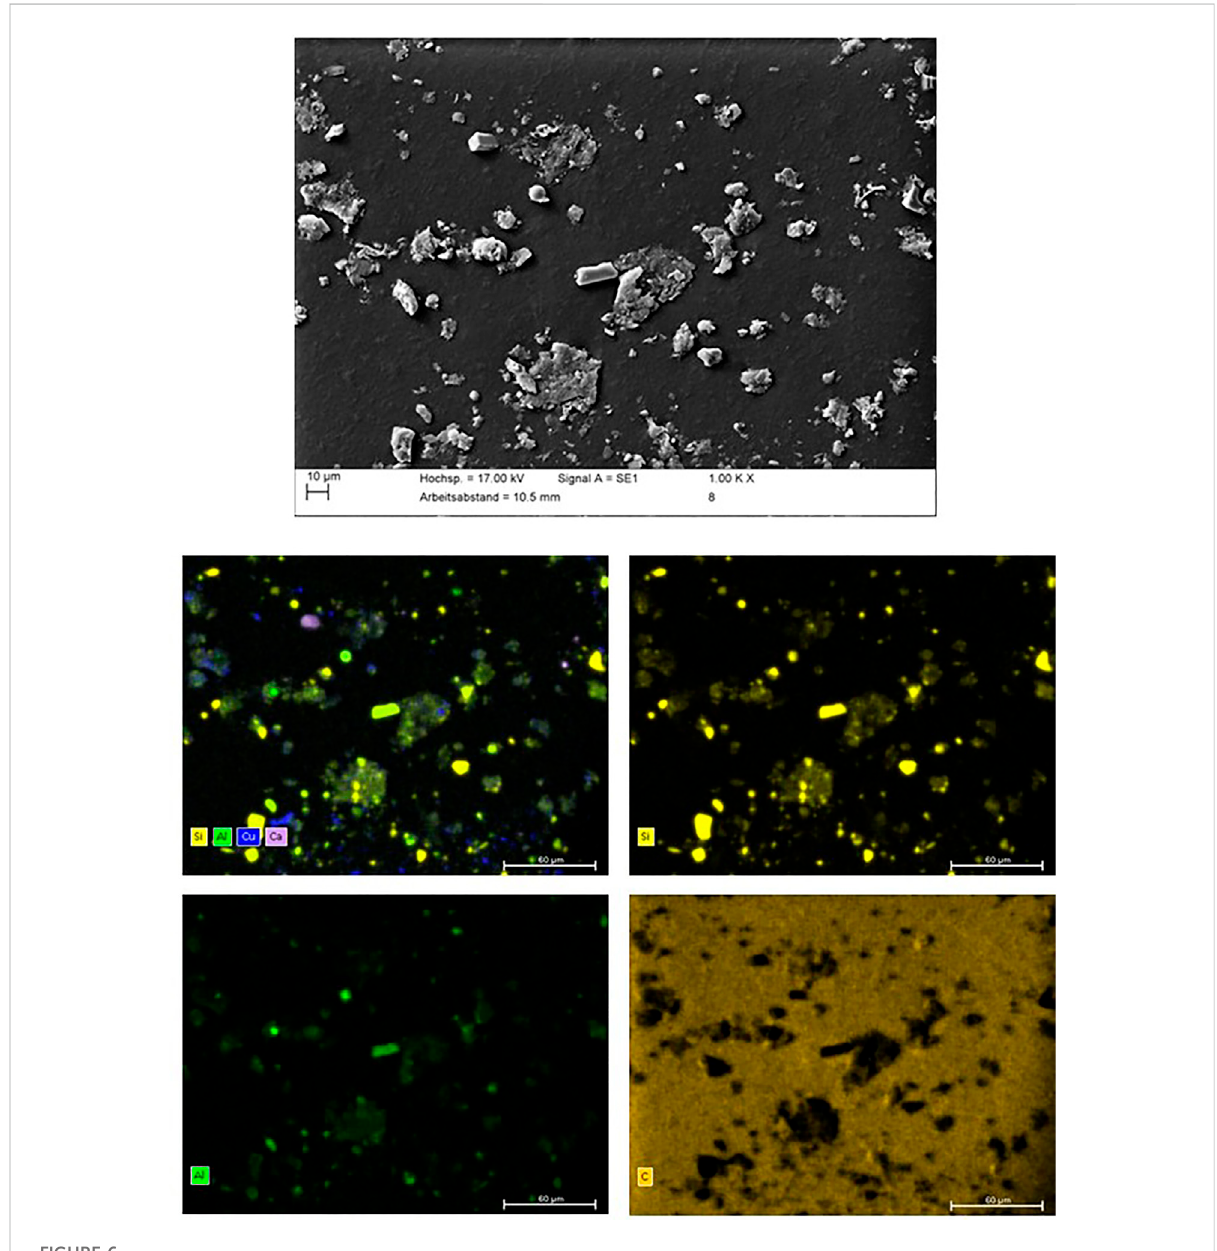
FIGURE 6 SEM and EDX analyses of a dust sample containing